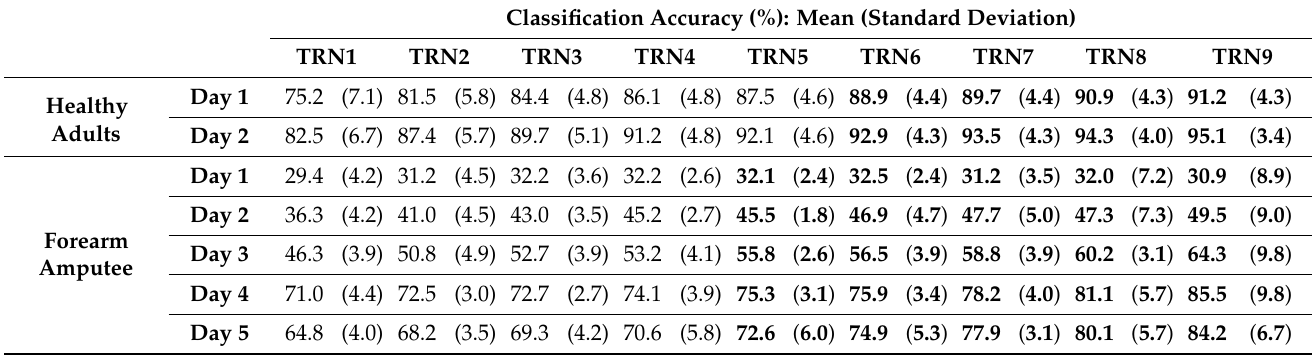
Table 3. Classification accuracy with visual feedback training using Hudgins’ set (bold: p < 0.05). Classification Accuracy (%): Mean (Standard